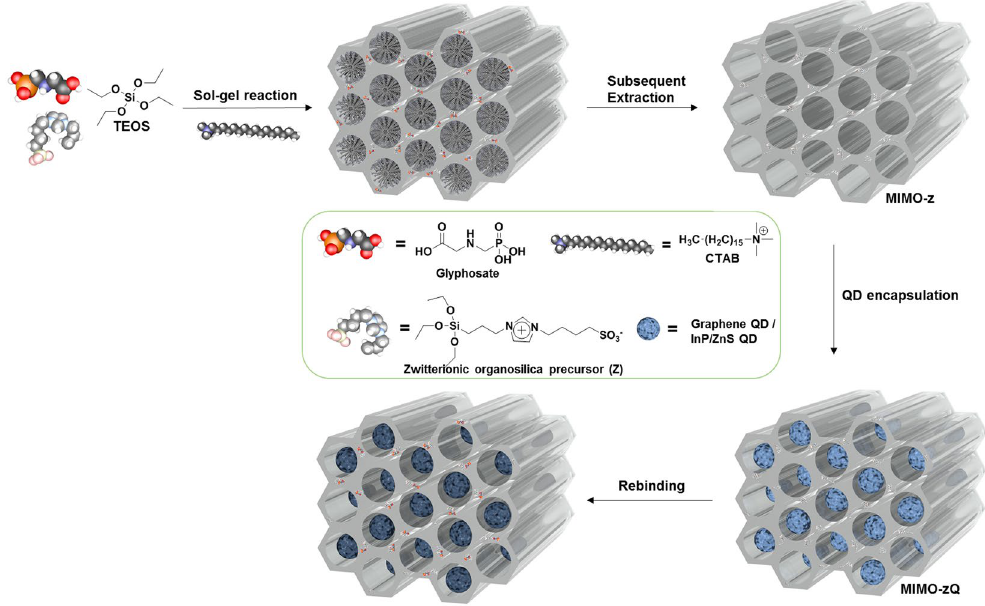
Figure 1. Schematic illustration of the synthesis of QD-encapsulated glyphosate imprinted mesoporous organosilica